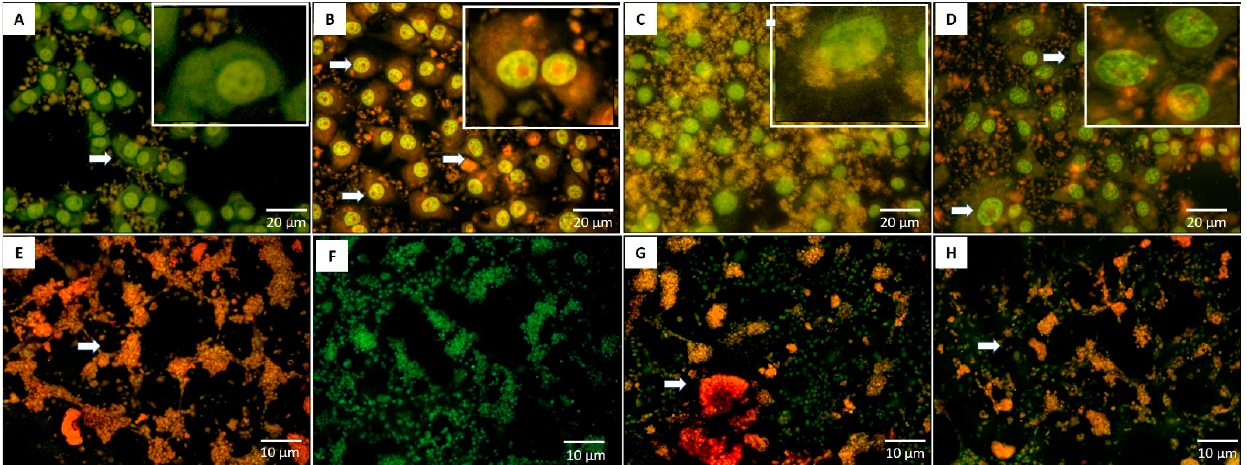
Figure 13. Fluorescence microscopy showing the morphology of MCF-7 cells and normal Vero cells stained with AO/EB after their exposure to ( A , E ) PCIBP, ( B , F ) EPCIBP, ( C , G ) Bev., or ( D , H ) a com- bination of EPCIBP and Bev. (arrows reveal early and late apoptotic stages; yellow is an early apop- totic stage. Red is a late apoptotic stage).